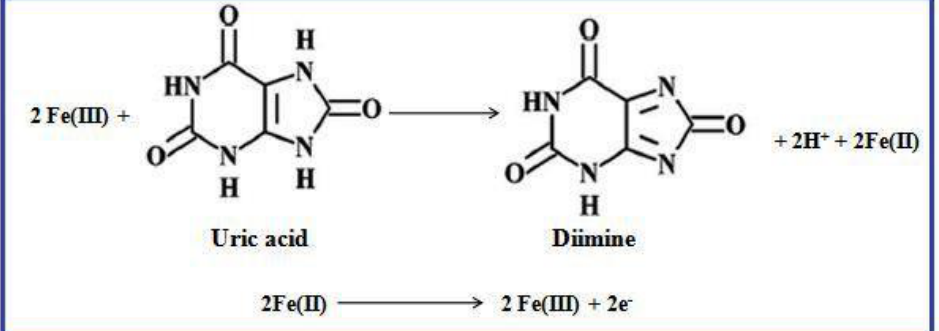
Scheme 1. Plausible Electrocatalytic Oxidation Mechanism of uric acid (UA) on γ-Fe 2 O 3 nanobelts/glassy carbon electrode (GCE).